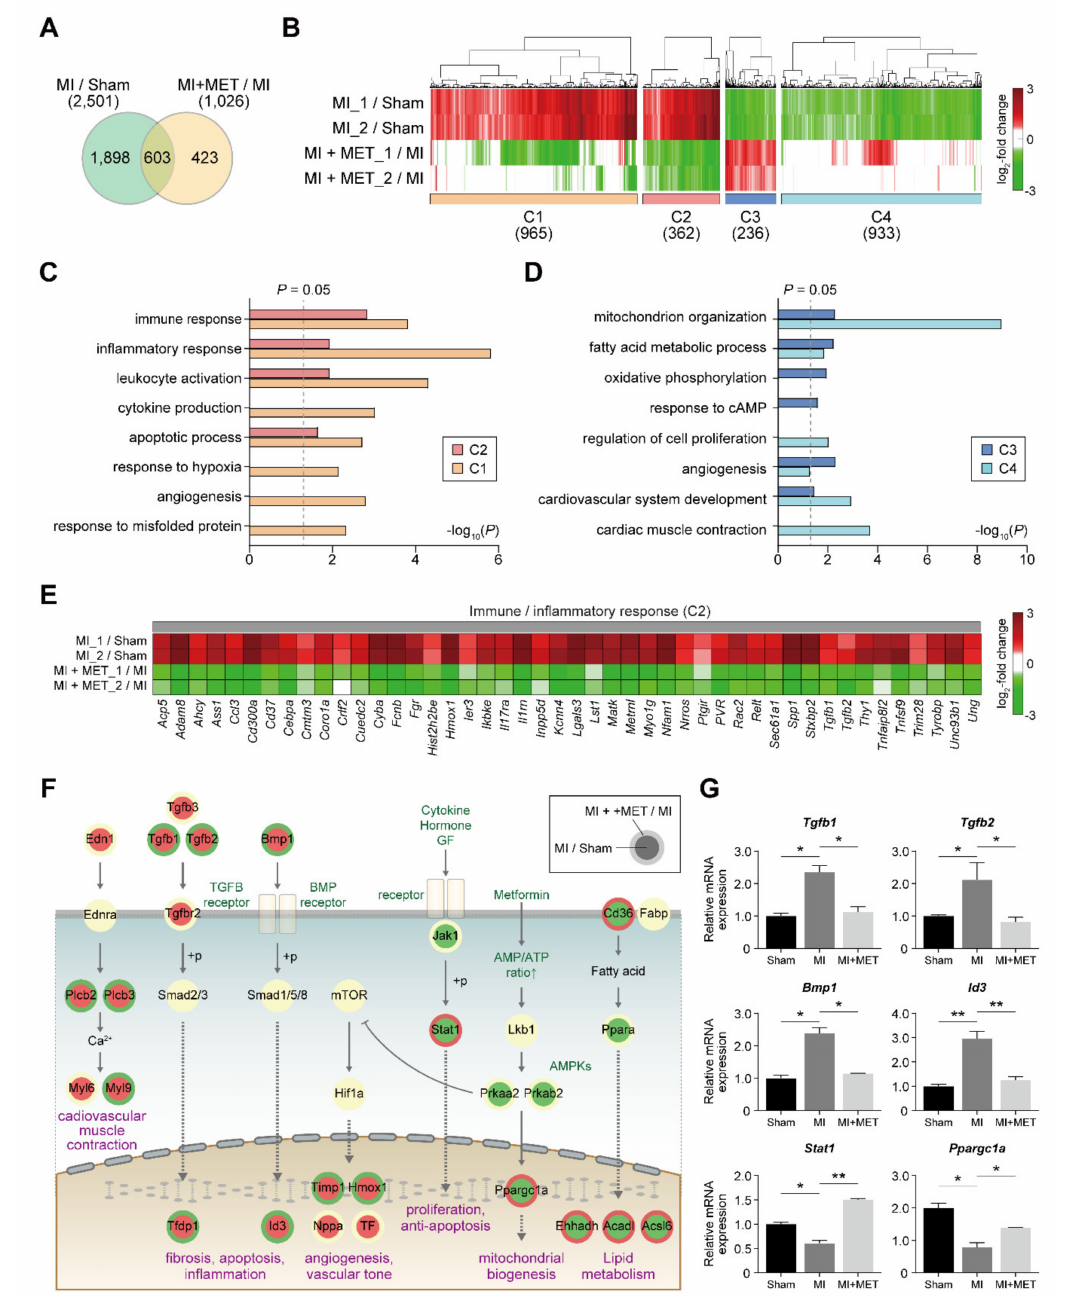
Figure 4. Cellular processes a ff ected by metformin treatment. ( A ) Relationships among DEGs from the two comparisons (Group B / Group A and Group D / Group B). ( B ) Clusters (C1-4) of genes a ff ected by metformin. Red and green denote up- and down-regulation, respectively. Color bar means gradient of log2-fold-changes. Numbers of DEGs in the comparisons of clusters are denoted in parenthesis ( A – B ). ( C – D ) Cellular processes enriched by DEGs in C1-4. X-axis, − log10(P) where p is the enrichment p -value calculated in DAVID software. ( E ) DEGs in C2 involved in the immune / inflammatory response. ( F ) Network model describing interactions among signaling pathways. Arrows and suppression symbols, activation and inhibition in signaling. “ + p”, phosphorylation. Red and green denote up- and down-regulation, respectively. ( G ) Gene expression levels obtained from mRNA-seq. The data are presented as mean ± SD. For each gene, all the significant di ff erences (see Materials and Methods) from the two comparisons were indicated by an asterisk: * p < 0.05 and ** p <